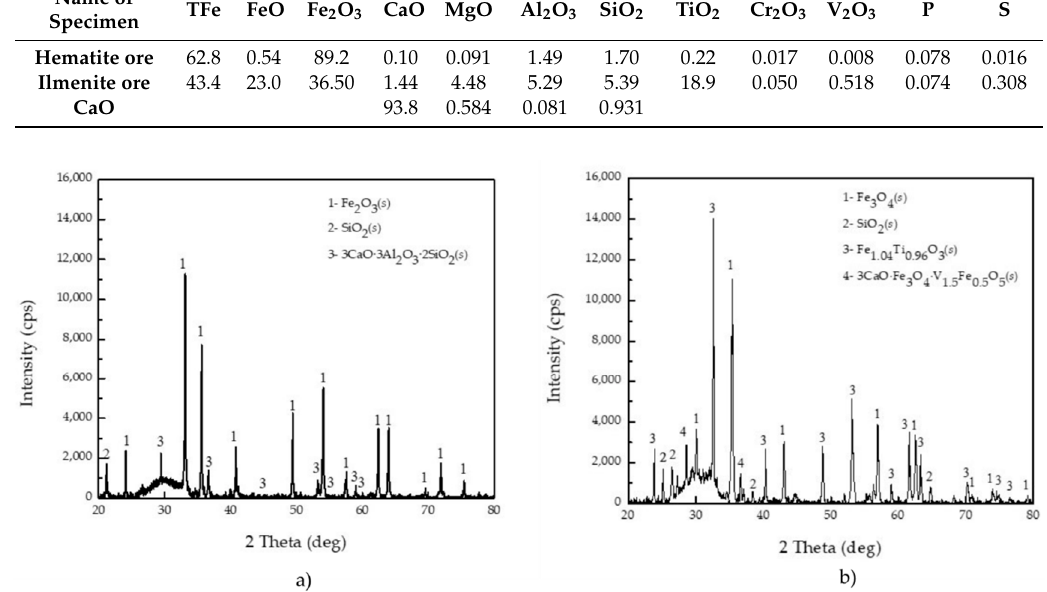
Table 1. Chemical composition of the hematite ore, ilmenite ore and calcium oxide used (wt%). Name of Specimen Hematite ore